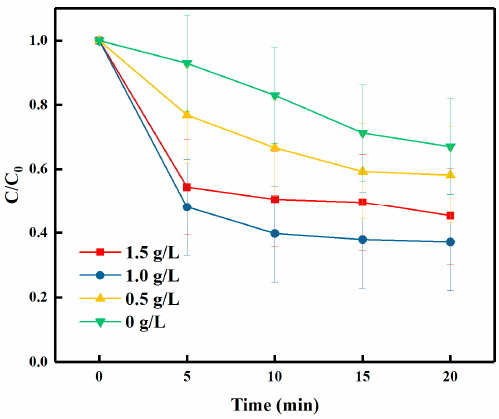
Figure 6. E ff ect of SCN / CoFe 2 O 4 dosage on the catalytic degradation of MB without ultrasonication. Experimental conditions: [MB] = 25 ppm, [catalyst] = 0–1.5 g / L, [H 2 O 2 ] = 4 vol %.